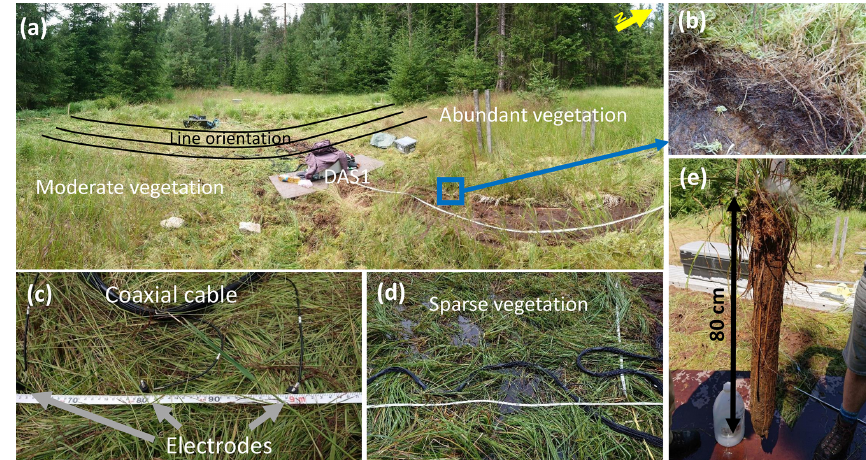
Figure 2. (a) Panoramic overview of the study site and the measurement setup. Pictures show the experimental setup and differences in the vegetation density between the northern and southern parts of the experimental plot. The induced polarization (IP) lines appear distorted due to the panoramic view. (b) Sphagnum in the northern part of the experimental plot. (c) Coaxial cables and stainless-steel electrodes used for IP measurements. (d) Vegetation and the coaxial cable bundle used for IP measurements in the water-covered area in the southeastern part of the experimental plot. (e) The freeze core shows the internal structure of the peat.